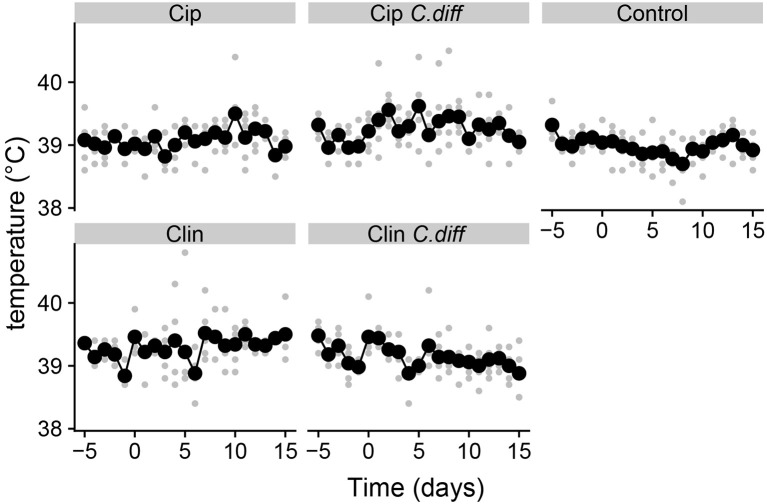
Elevated temperatures in Clindmycin and C. difficile-treated pigs. Rectal temperatures for pigs were significantly higher in the Clin, Clin C. diff, and Cip C. diff treatments relative to controls, on average (p < 0.01). A single diurnal sample is shown per pig, per day in gray. Daily means per treatment are displayed in black and connected with lines. Temperature was measured at the same time each day.